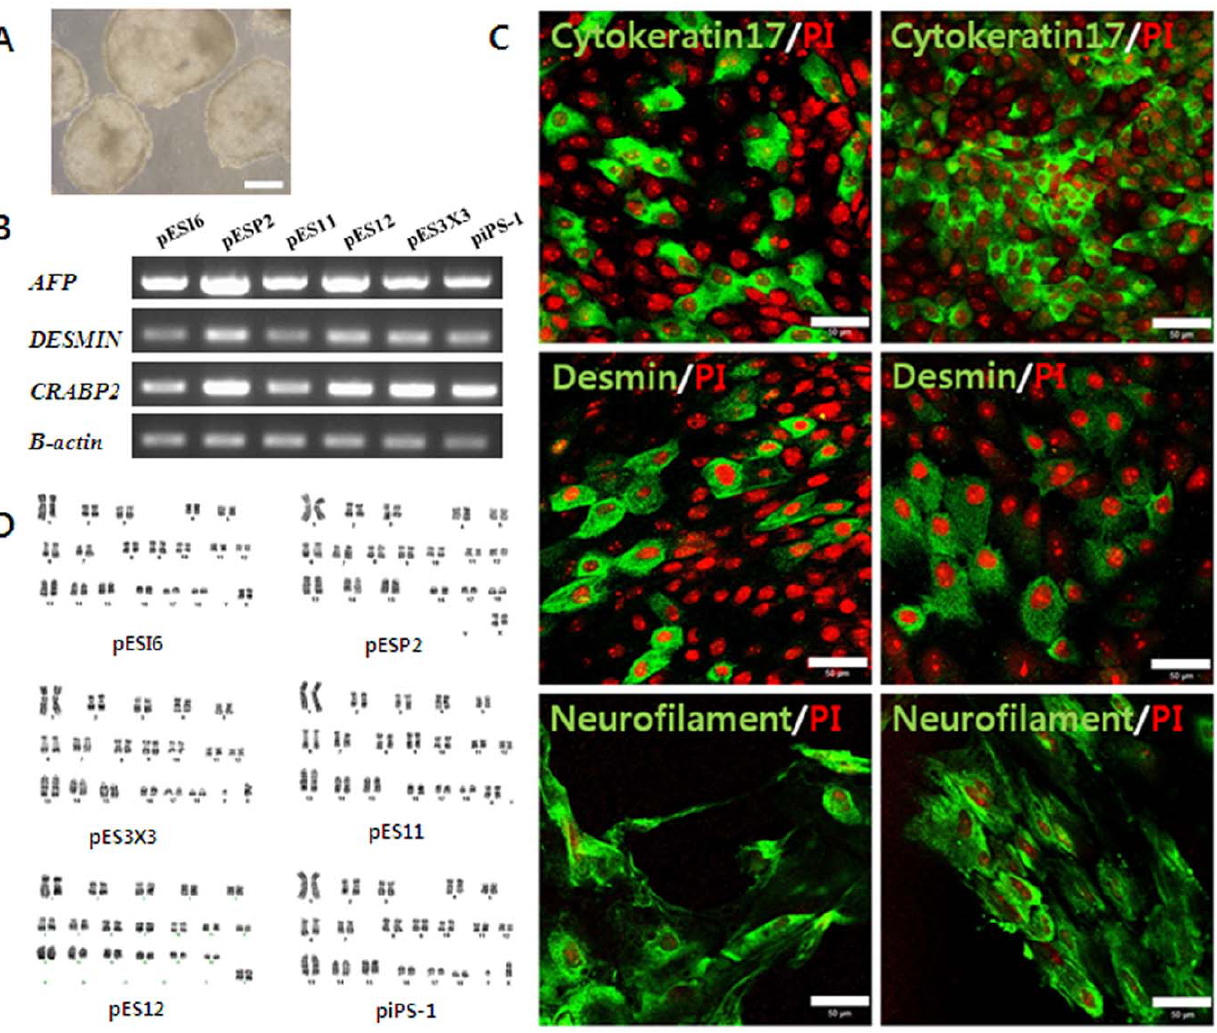
Figure 5. Differentiation potential and karyotyping of EpiSC-like pESCs and piPSCs. ( A ) Representative embryoid bodies derived from EpiSC-like pES cell lines and piPS cell lines through the culture for 5 days by hanging drop method. ( B ) When EBs cultured continuously onto culture plates, a variety of differentiated cells was observed. We could detect the expression of marker genes AFP (endoderm), DESMIN (mesoderm) and CRABP2 (ectoderm) involving differentiation. ( C ) Confirmation of the expression of differentiation marker Cytokeratin 17 (endoderm), Desmin (mesoderm) and Neurofilament (ectoderm) from differentiated cells by the immunocytochemistry analysis. Left lane is the cells differentiated from EpiSC-like pESCs and right lane is the cells differentiated from EpiSC-like piPSCs. ( D ) Both EpiSC-like pESCs and piPSCs have a normal karyotyping. Scale bars=50 m m.